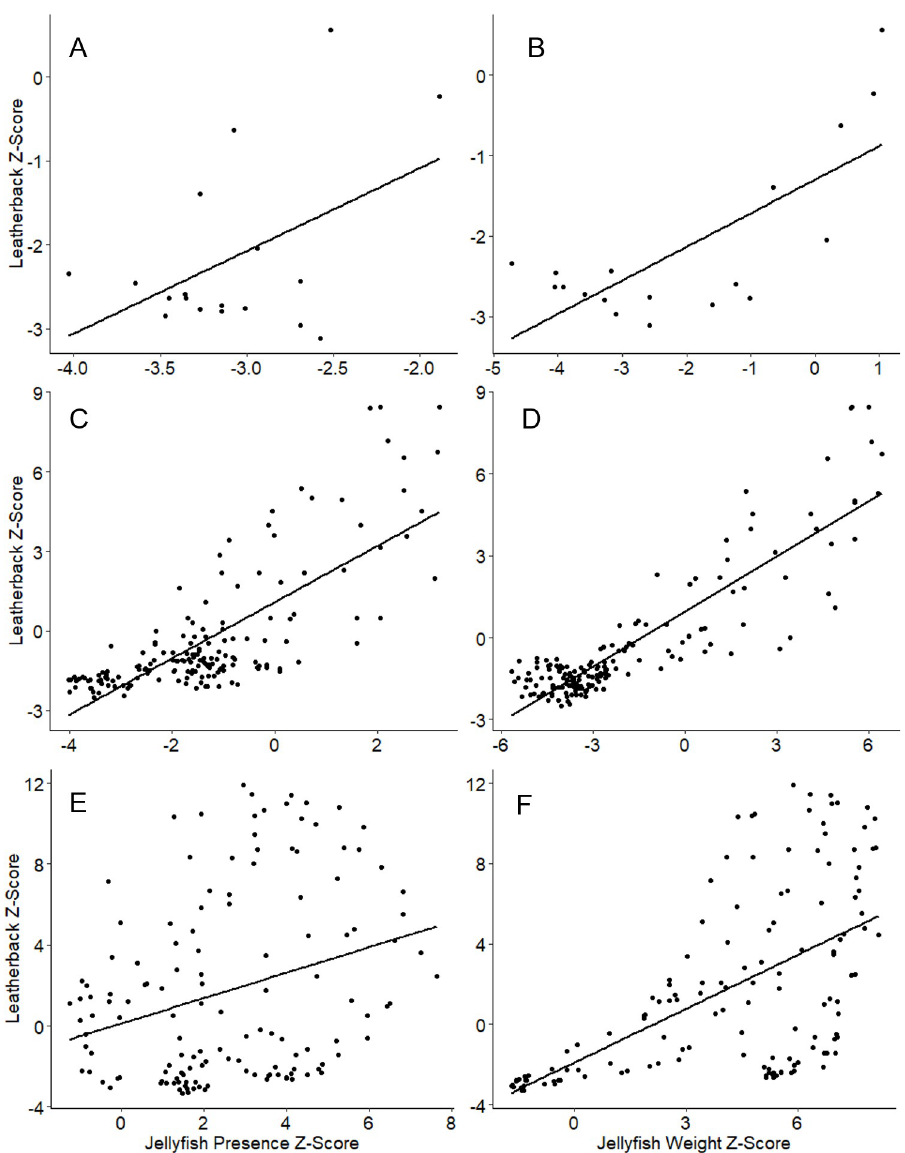
Fig 4. Predicting turtle habitat use from jellyfish data. Hot spot analysis z-scores compared for leatherbacks and jellyfish in each region with line of best fit. A) Bay of Fundy leatherback z-scores and jellyfish presence z-scores (r = 0.464, n = 18, p = 0.052); B) Bay of Fundy leatherback z-scores and jellyfish weight z-scores (r = 0.744, n = 18, p < 0.001); C) Scotian Shelf leatherback z-scores and jellyfish presence z-scores (r = 0.756, n = 166, p < 0.001); D) Scotian Shelf leatherback z-scores and jellyfish weight z-scores (r = 0.881, n = 166, p < 0.001); E) Gulf of St. Lawrence leatherback z-scores and jellyfish presence z-scores (r = 0.295, n = 137, p < 0.001); and F) Gulf of St. Lawrence leatherback z-scores and jellyfish weight z-scores (r = 0.588, n = 137, p < 0.001).